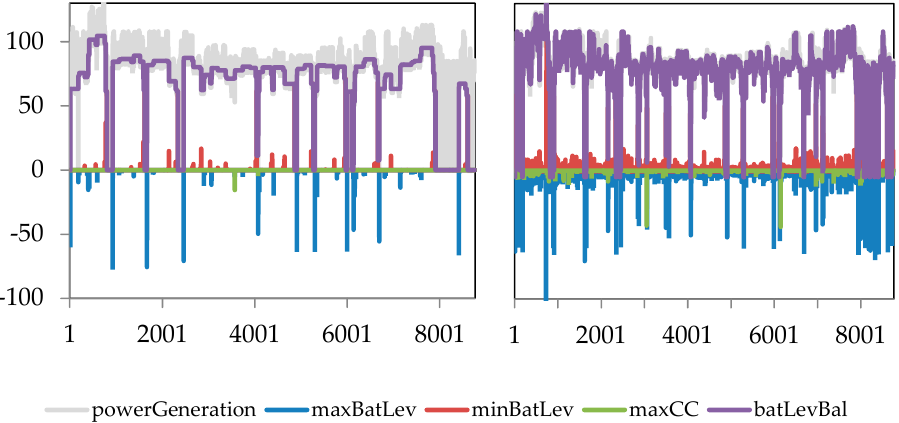
Figure A11. Marginal values of equations of the BEV modeling equations in REMix for the full year for scenario S1 ( left ) and S2 ( right ).